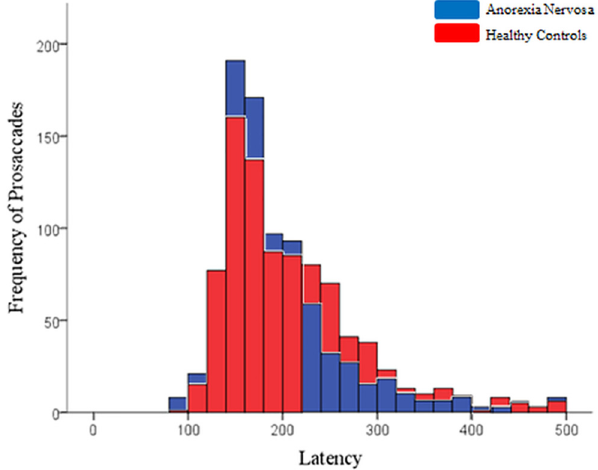
Fig 3. Frequency of individual prosaccade latencies within 20 millisecond bins.